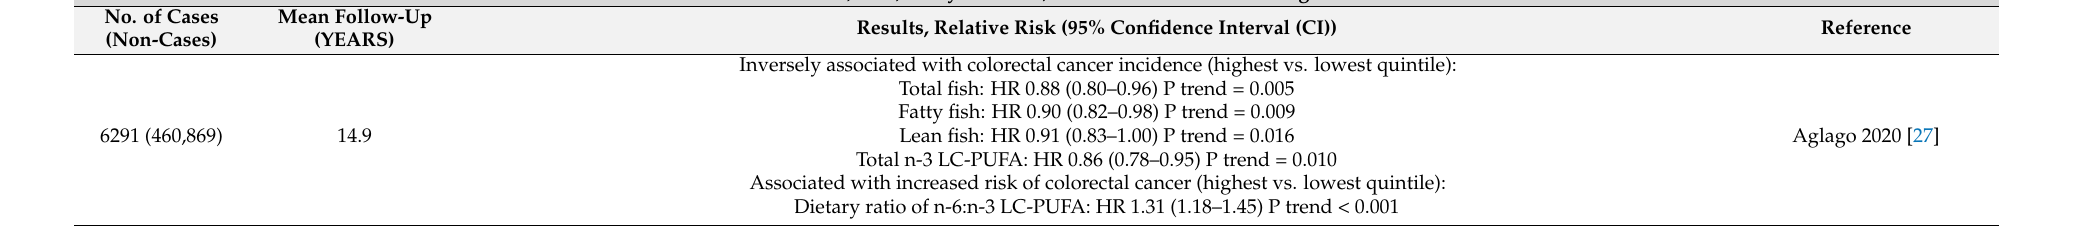
Subjects with higher concentrations of red blood cell stearic acid were at higher risk for colorectal cancer (per 1 mol%): OR 1.23 (1.07–1.42). Conversely, colorectal cancer incidence decreased with increasing proportions of red blood cell n-3 PUFA, particularly eicosapentaenoic acid (per 1 mol%): OR 0.75 (0.62–0.92). Dietary Patterns No. of Cases The meat-eaters pattern (meat, poultry, and margarine) was positively associated with colorectal cancer risk (highest vs. lowest quintile): RR 1.58 (0.98–2.53) P trend = 0.02 For colorectal cancer in vegetarians compared with meat eaters: IRR 1.39 (1.01–1.91). Comparing vegetarians with nonvegetarians, the risk of NR colorectal cancer was significantly higher among vegetarians: IRR 1.49 (1.09–2.03). The Italian Mediterranean Index was inversely associated with colorectal cancer risk (highest vs. lowest category): HR 0.50 (0.35–0.71) P trend = 0.043. Highest Italian 11.28 Mediterranean Index score was also significantly associated with reduced risks of any colon cancer: HR 0.54 (0.36–0.81), distal colon cancer: HR 0.44 (0.26–0.75), and rectal cancer: HR 0.41 (0.20–0.81), but not of proximal colon cancer. A decreased risk of colorectal cancer was estimated when comparing the highest (scores 6–9) with the lowest (scores 0–3) adherence to the Centre-Specific Modified Mediterranean diet score and the Modified Mediterranean diet score: HR 0.92 (0.84–1.00) and HR 0.89 (0.80–0.99), respectively. A 2-unit increment in either Mediterranean scale was associated with a borderline statistically significant reduction in colorectal cancer risk (for the Modified Mediterranean diet score): HR 0.96 (0.92–1.00) 11.0 Adherence to Mediterranean diet (highest vs. lowest quartile): RR 0.50 (0.35–0.71) P trend = 0.043 A higher Food Standards Agency nutrient 15.3 profiling system dietary index (FSAm-NPS DI) score (lower nutritional quality diet) was associated with a higher risk of colorectal cancer (highest fifth vs. lowest quintile): HR 1.11 (1.01–1.22) P trend = 0.02 More proinflammatory diets were related to a higher colorectal cancer risk, particularly for colon cancer: Inflammatory Score of the Diet quartile (highest vs. lowest quintile): HR 1.15 (1.04–1.27) for colorectal cancer risk, HR 1.24 (1.09–1.41) for colon cancer, and HR 0.99 (0.83–1.17) for rectal cancer. 14.0 Associations were more pronounced in men and not significant in women. The inflammatory profile score of the diet was associated with colorectal cancer risk, particularly colon cancer among men (highest vs. lowest quintile): HR 1.62 (1.31–2.01) for colon cancer overall, and HR 2.11 (1.50–2.97) for colon cancer in